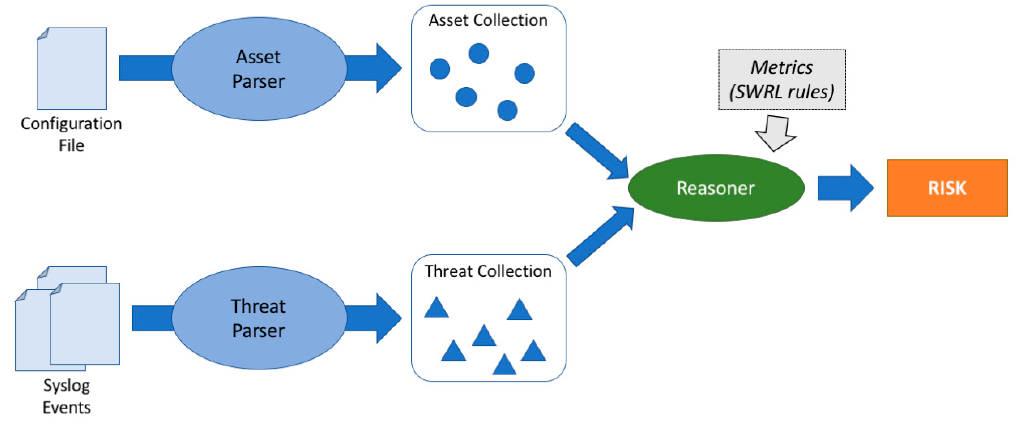
Figure 7. High level scheme of system operation.